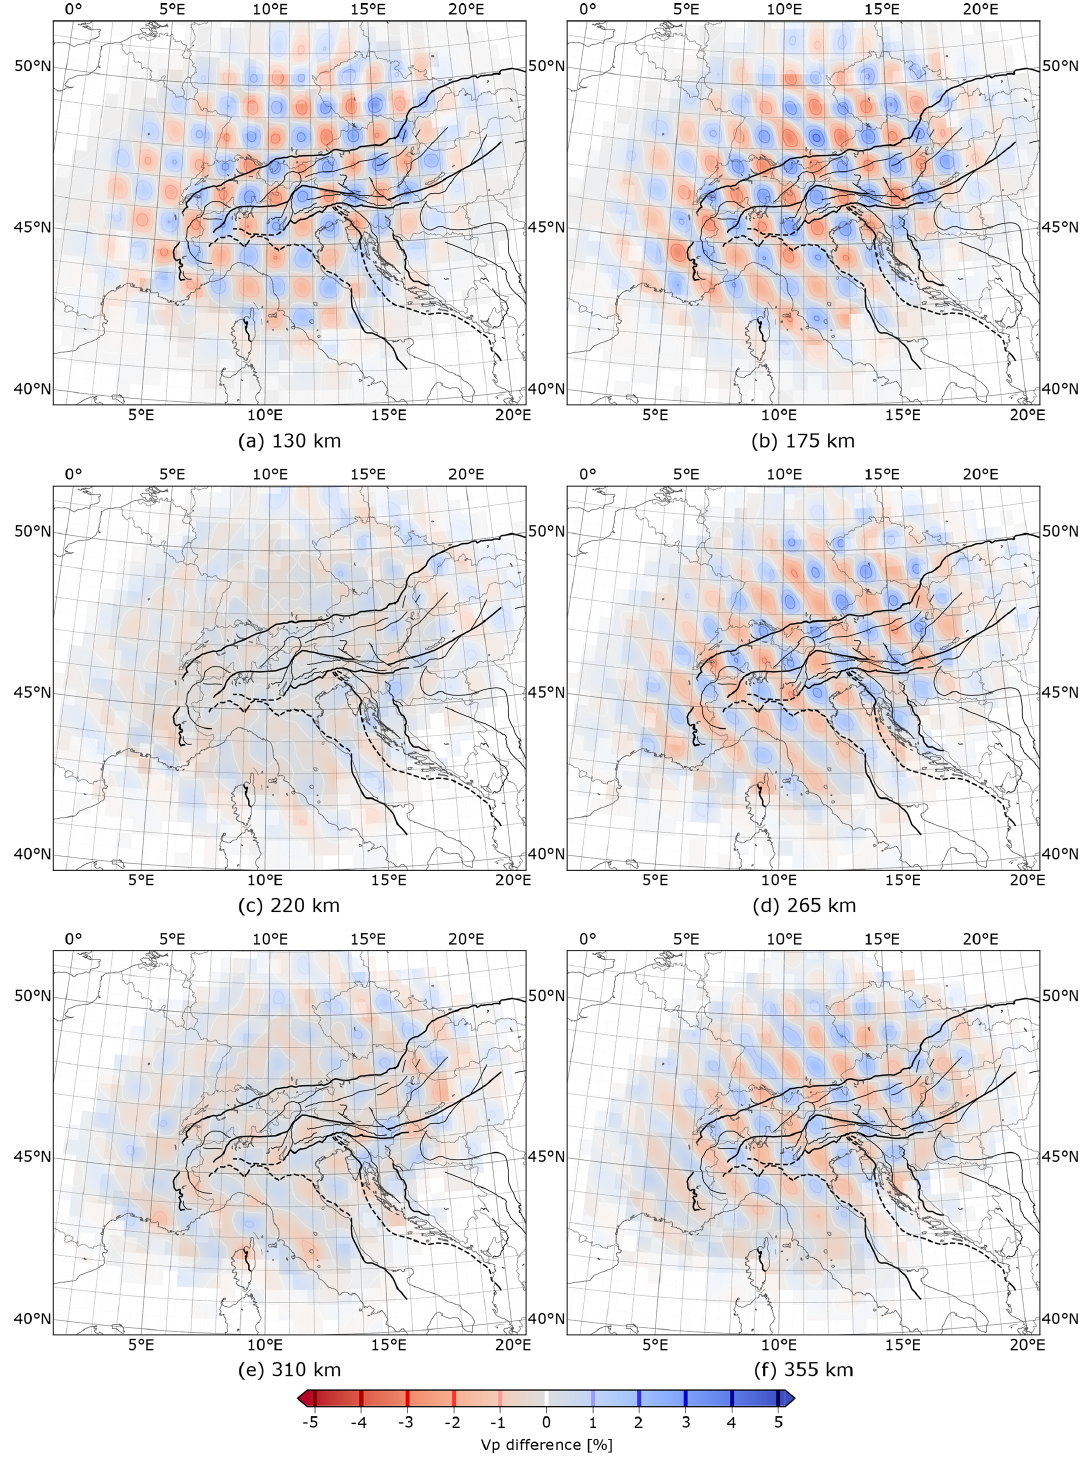
Figure 9. Results of checkerboard analysis after 12 iterations for the 2 × 2 × 3 grid. Misfit reduction is 72%. Here, slices in the right panels cut through centre of velocity anomalies. Left panel slices cut through unperturbed space in between.